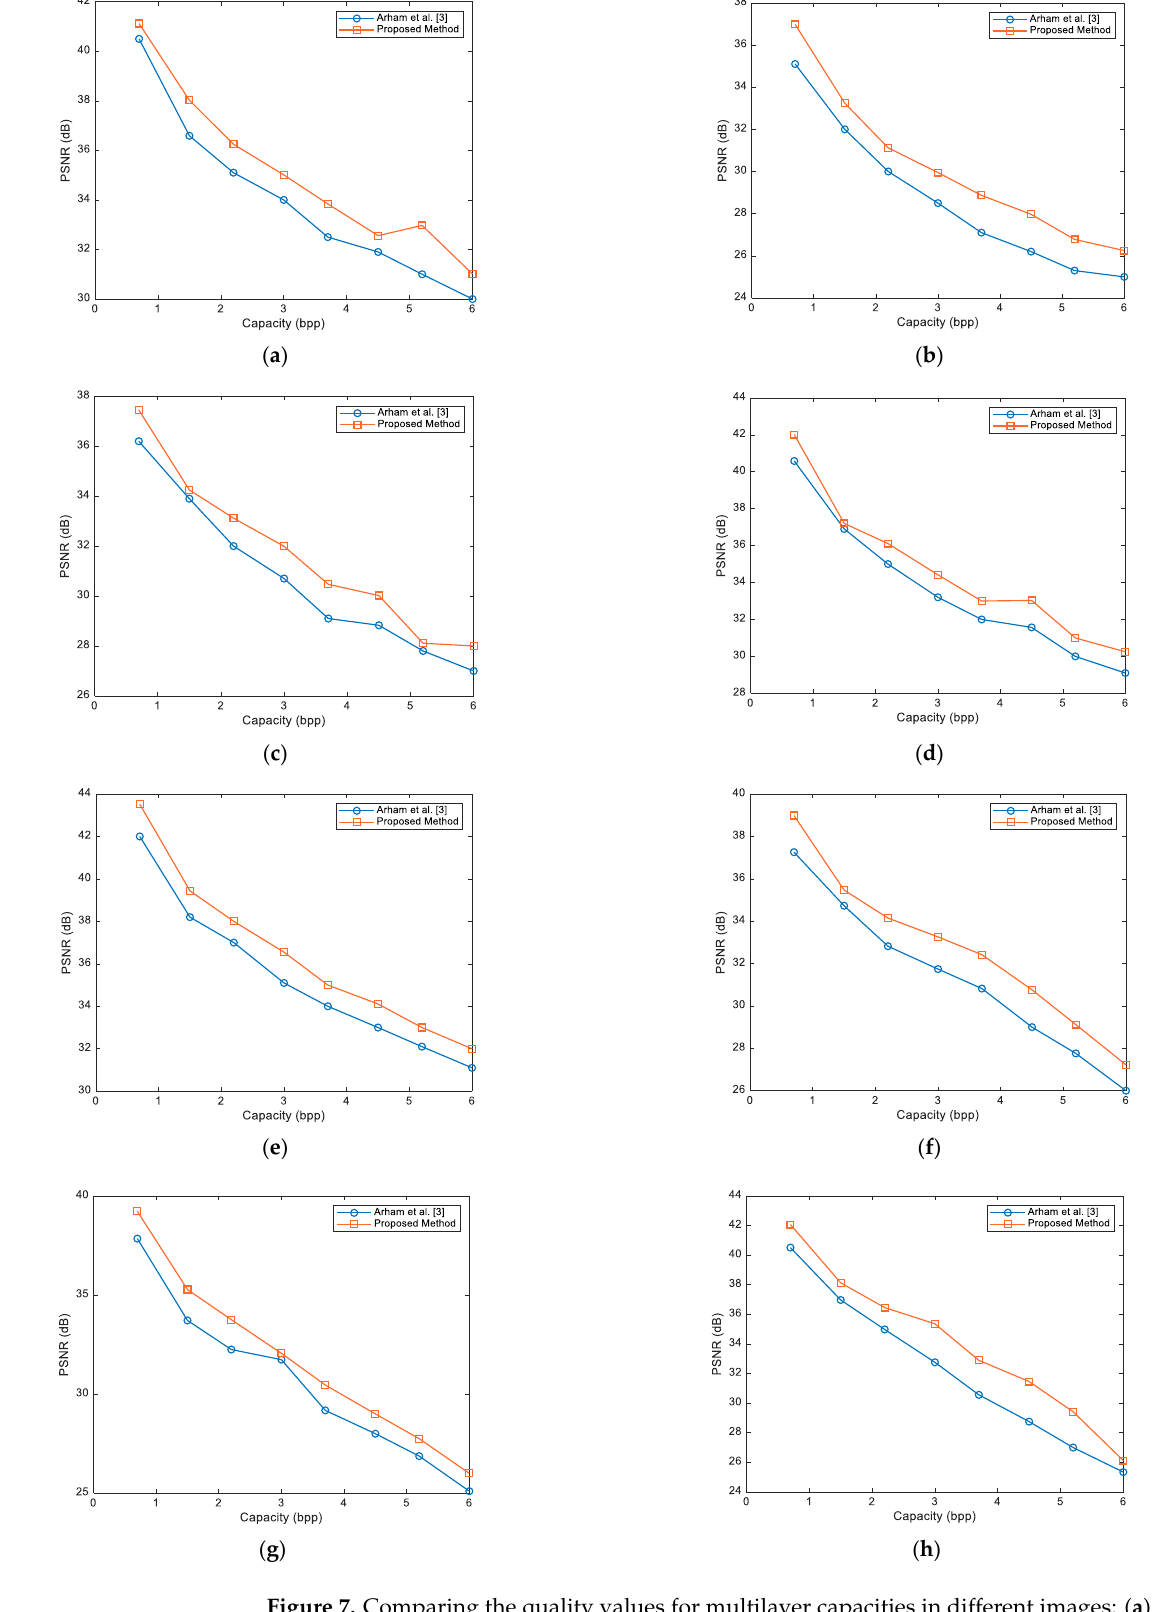
Figure 7. Comparing the quality values for multilayer capacities in different images: ( a ) Airplane; ( b ) Baboon; ( c ) Barbara; ( d ) Ship; ( e ) Lena; ( f ) Peppers; (g) Lake; ( h ) Bridge [3].